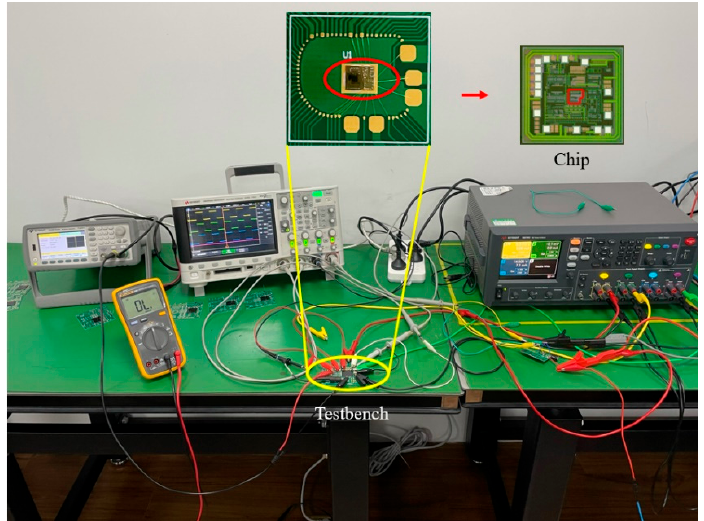
Figure 7. Chip micrograph and testbench of the buck converter with the proposed bootstrap circuit.